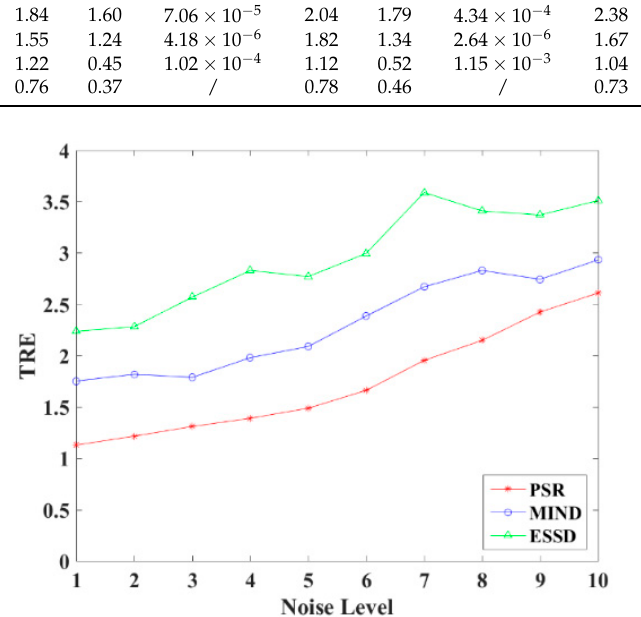
Figure 11. TRE for different noise levels.